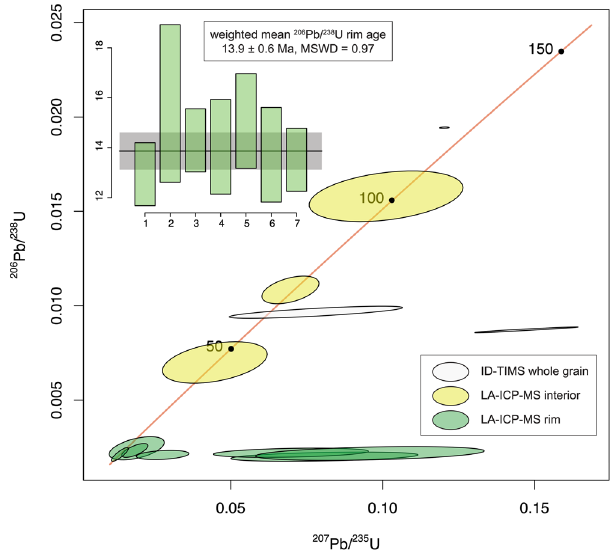
Fig. 3 Wetherill Concordia diagram showing zircon U-Pb dating results. See legend at the bottom for the types of data represented by ellipses on the plot. The bar graph inset shows the weighted mean 206 Pb/ 238 U age for the seven zircon rim analyses. ID-TIMS = isotope dilution thermal ionization mass spectrometry; LA-ICP-MS = laser ablation inductively coupled plasma mass